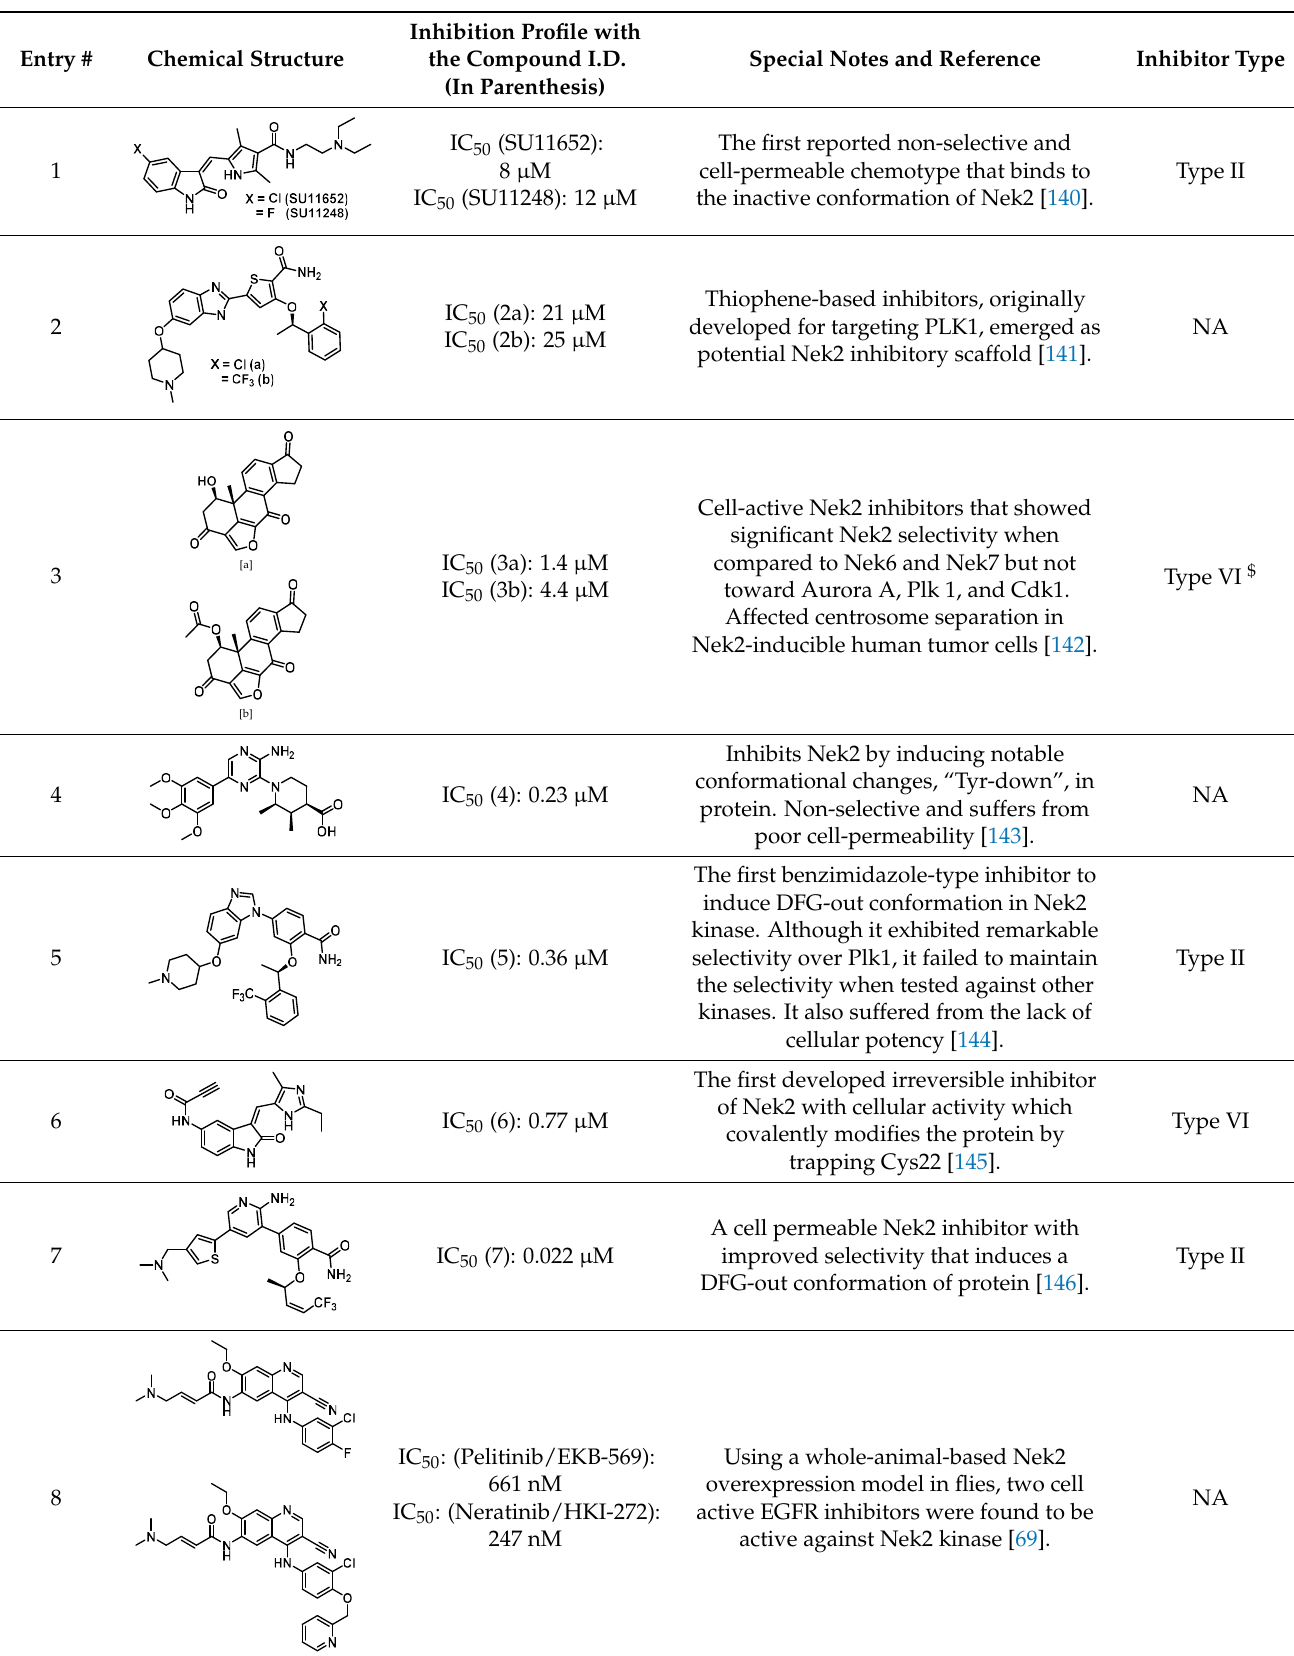
Table 1. Small Molecule Inhibitors of Nek2 Activity and Their Cellular Profile.